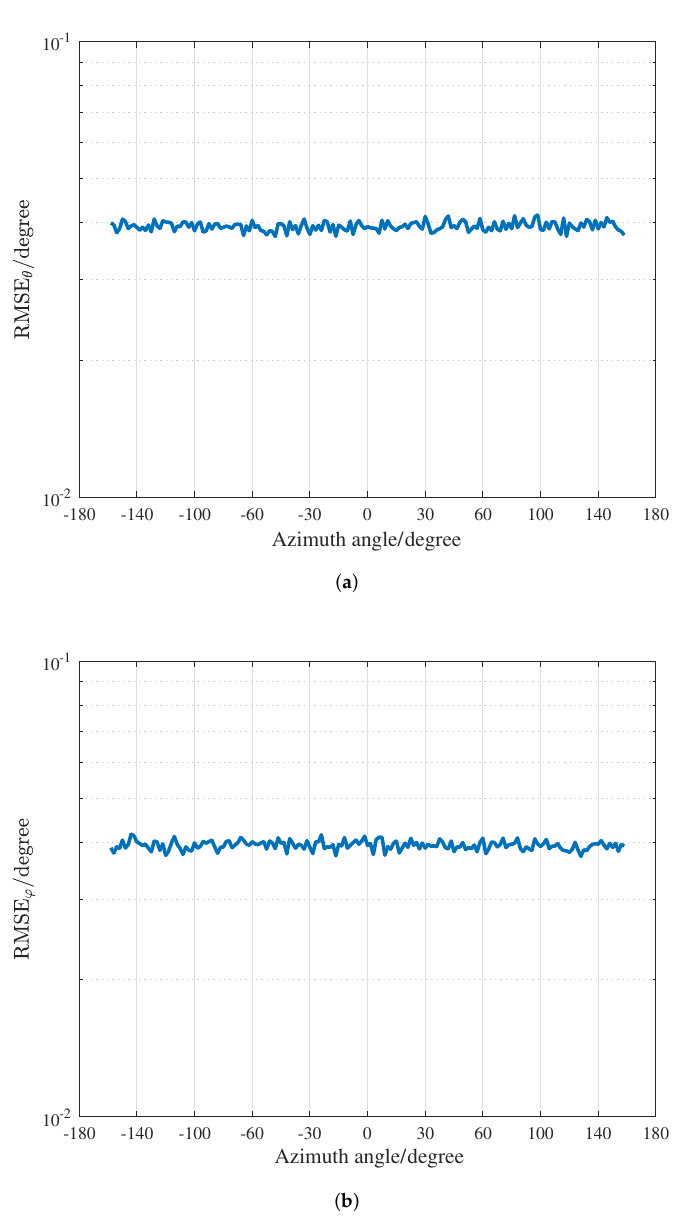
Figure 7. RMSEs versus the azimuth angle when θ = 45 ◦ . ( a ) RMSE of elevation. ( b ) RMSE of